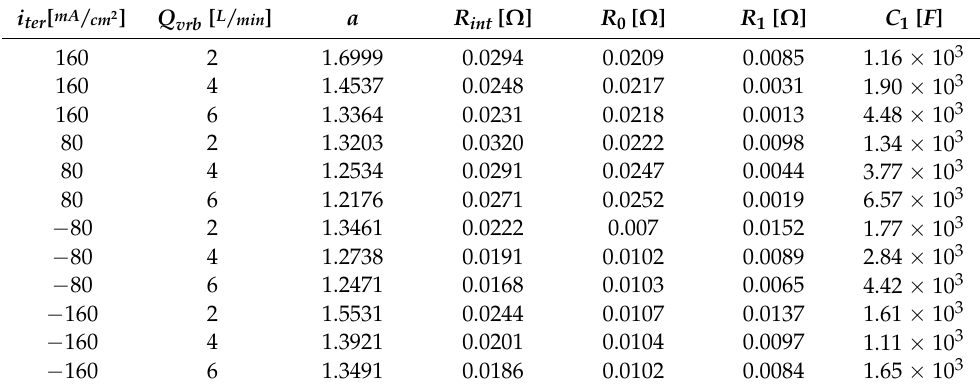
Table 1. ECM parameters under different current densities and flow volume rates.